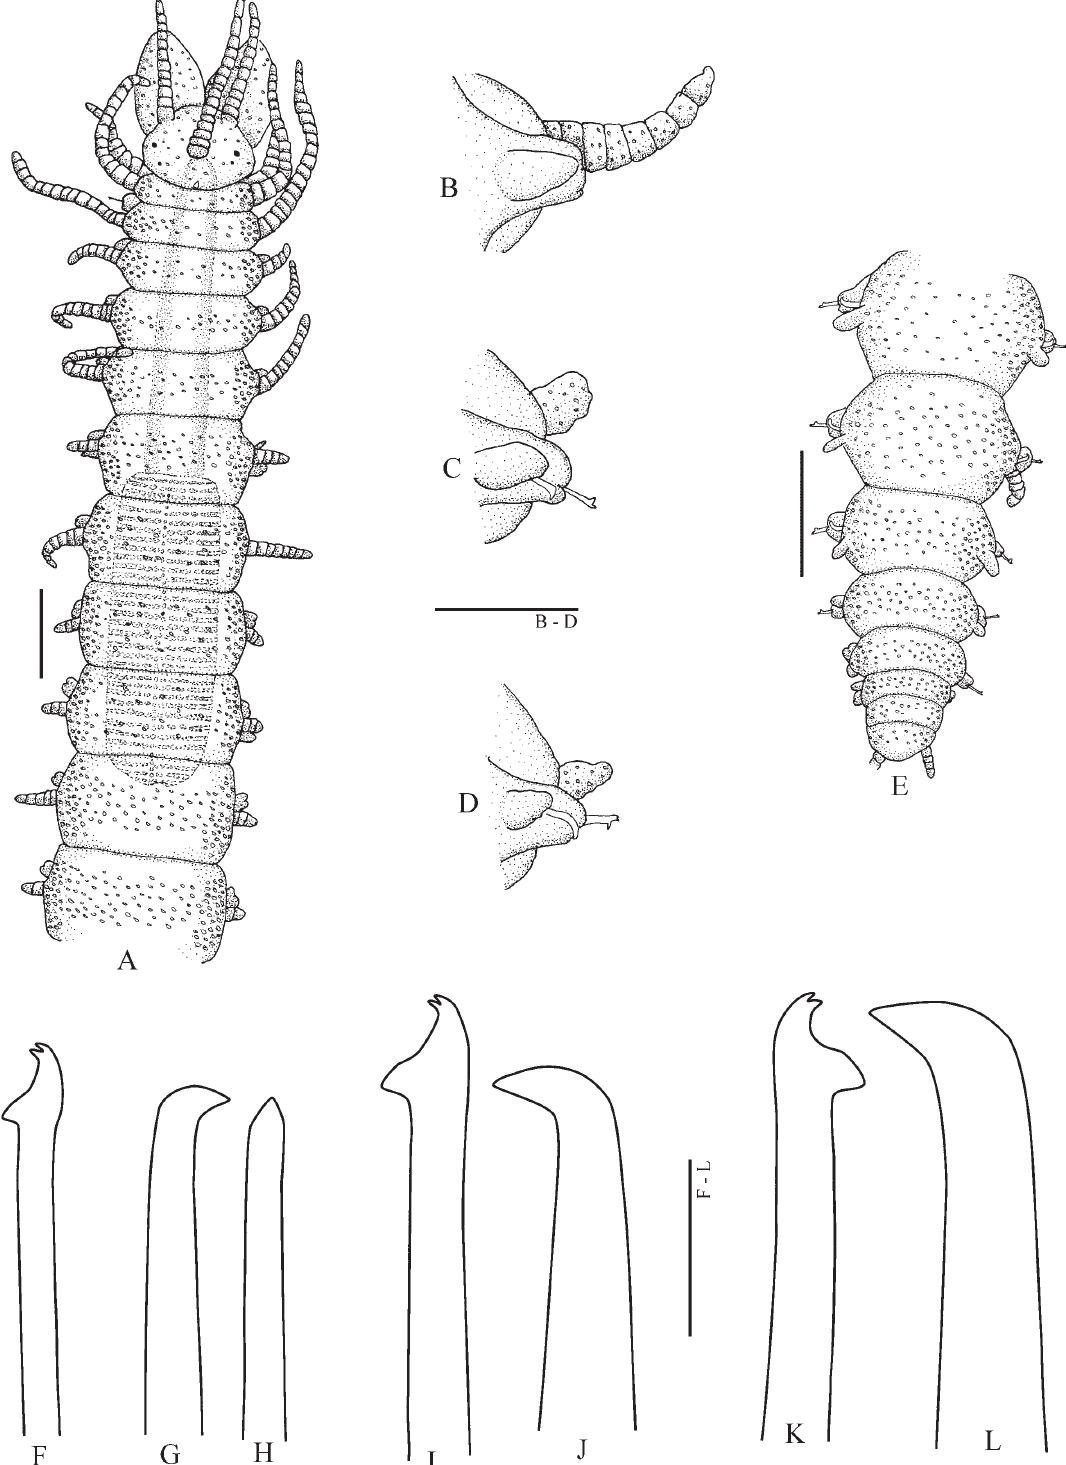
Fig . 6. – Hand-drawing of Haplosyllis cephalata . A, anterior end, dorsal view. B, anterior parapodium, chaetiger 2. C, mid-body parapodium of post-proventricular region. D, posterior parapodium. E, posterior end, dorsal view. F, chaeta of chaetiger 3. G, acicula with curved tip, chaetiger 3. H, acicula with straight tip, chaetiger 3. I mid-body chaeta. J, mid-body acicula. K, posterior chaeta. L, posterior acicula. Scale bars: A, E (200 m m), B-D (100 m m), F-L (20 m m). INV−ANE